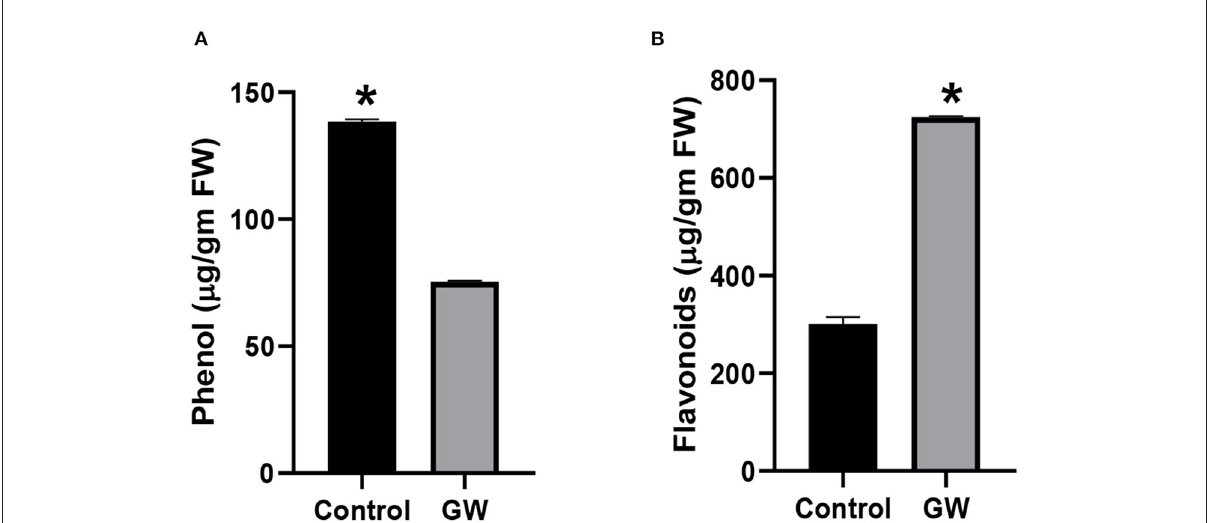
FIGURE6 Determination of (A) phenol and (B) flavonoid in the leaves of A. fatua seedlings grown in the presence and absence of endophytic fungus F. oxysporum GW. Bars show the mean of three replicates with standard deviation. Bars labeled with * are significantly higher ( t -test; p <